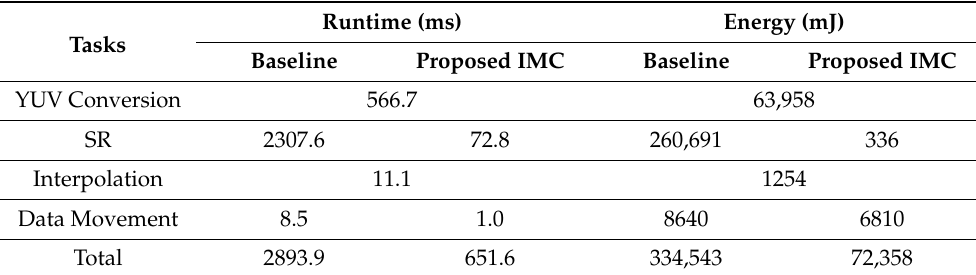
Table 2. Runtime and energy comparison for on-line